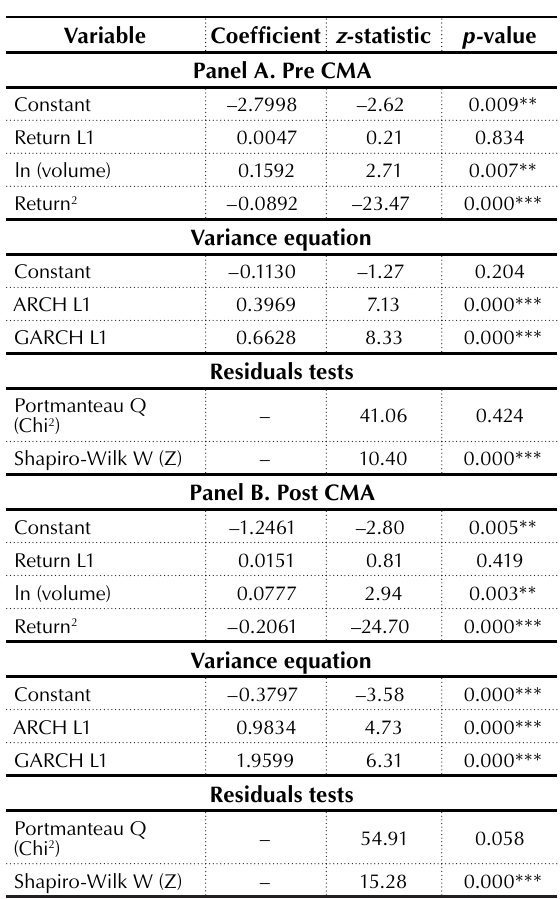
Table 5. GARCH (1,1) of volume, return, volatility relationship pre and post CMA